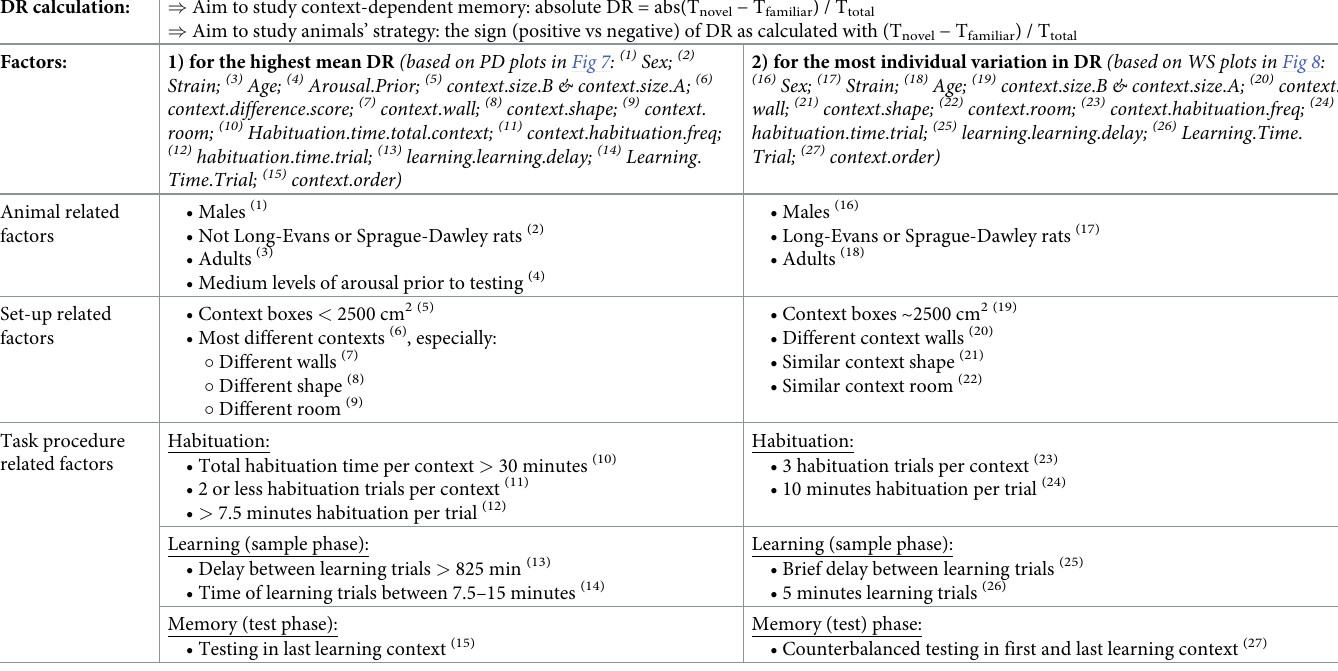
Table 1. Recommendations for future animal